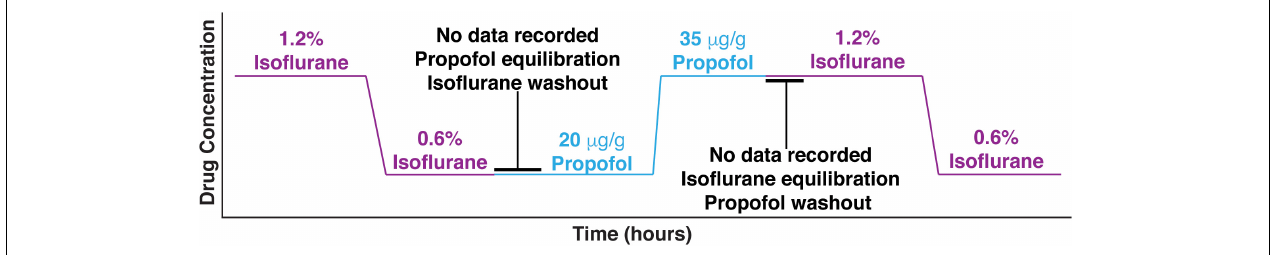
FIGURE 1 | Experimental design. Mice were first given two doses of isoflurane (high – 1.2%, and low – 0.6%), then given two doses of propofol (low – 20 µ g/g brain and high – 35 µ g/g brain). Between isoflurane and propofol recordings, the brain was allowed 45 min to wash out isoflurane and establish equilibrium with propofol. Four out of 7 mice were re-exposed to the high and low isoflurane doses after propofol was washed out for 1 h.